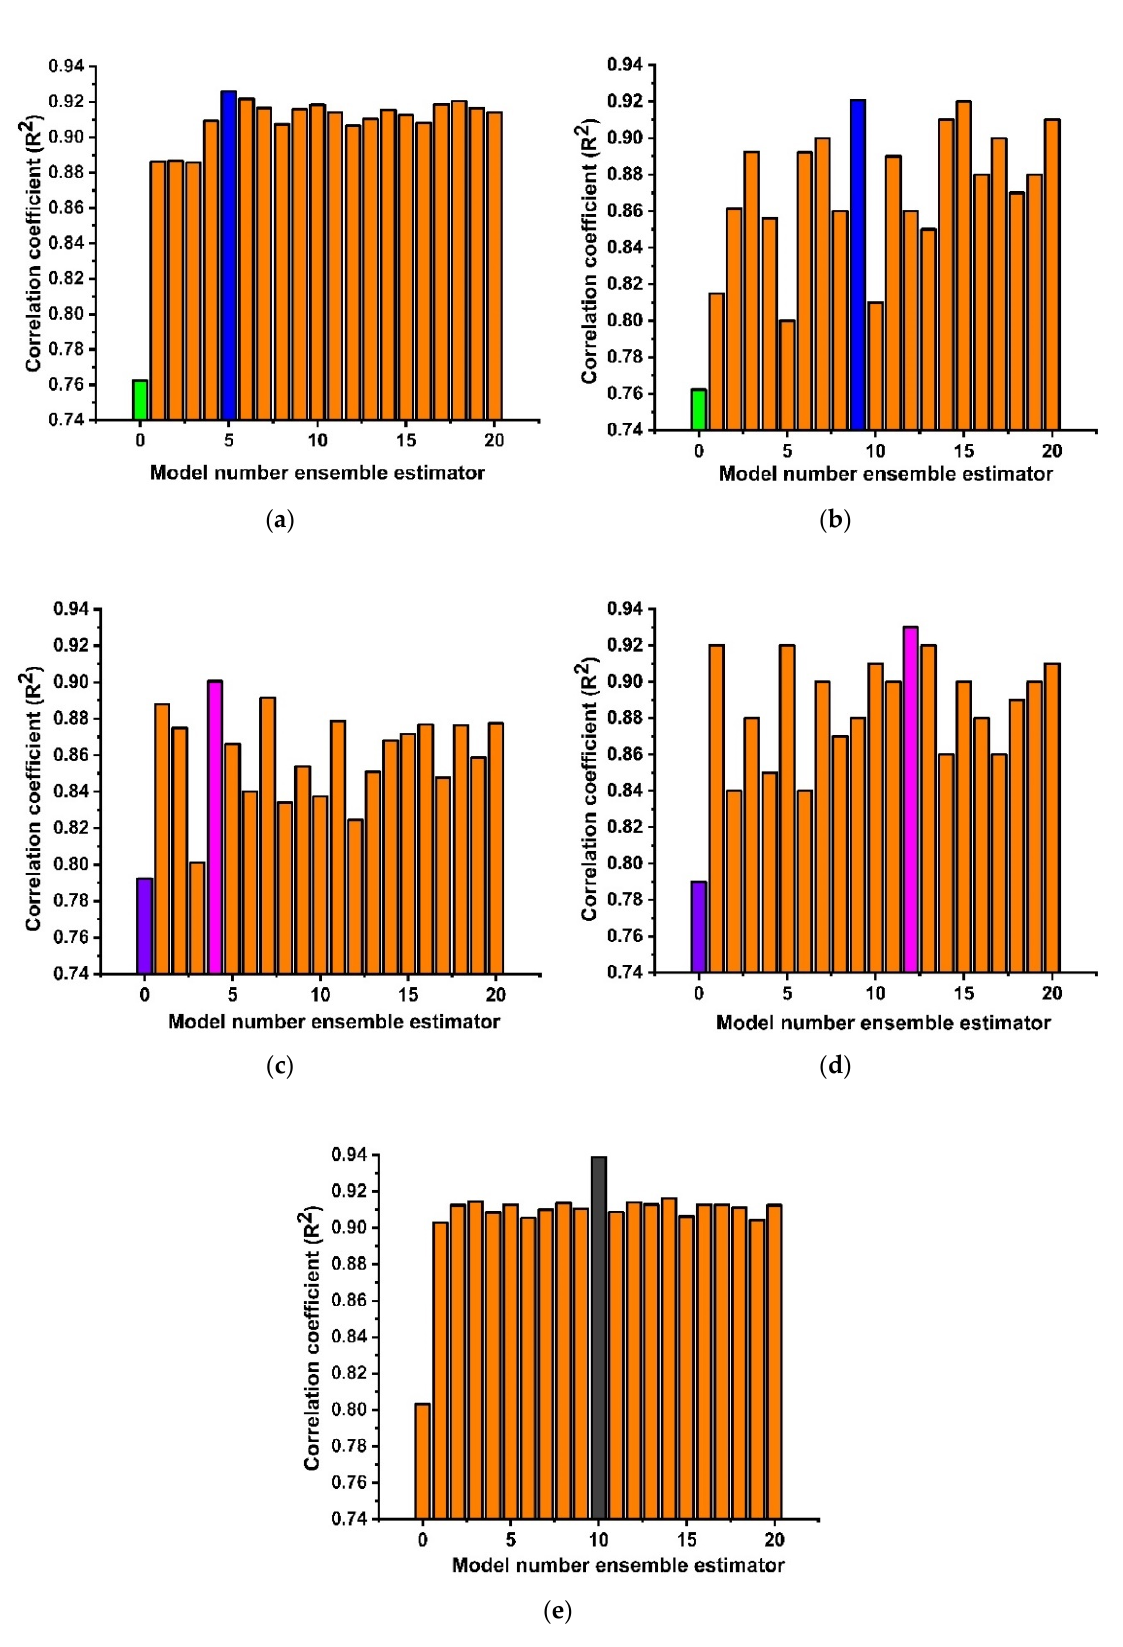
Figure 3. Ensemble modeling ( a ) DT with AdaBoost algorithm; ( b ) DT with bagging algorithm; ( c ) SVR with AdaBoost algorithm; ( d ) SVR with bagging algorithm; ( e ) RF ensembling.